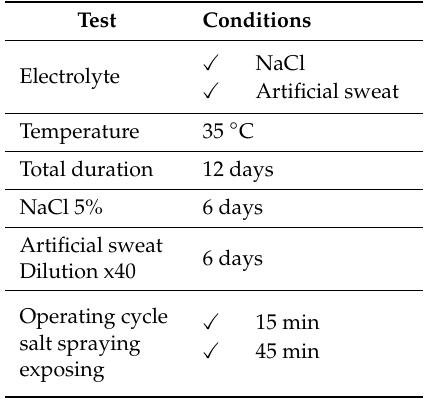
Table 2. The salt fog test conditions.